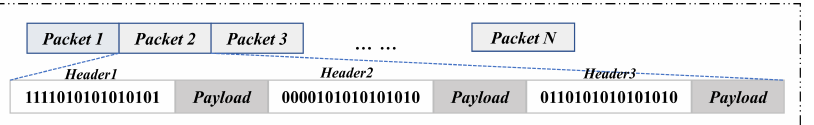
Figure 9. Offline processing of OCC decoding scheme. ( a – c ) are respectively R, G, and B signals of the raw column selected; ( d – f ) are respectively the R, G, and B signals of the selected column after enhancement; ( g ) Block diagram of the proposed offline OCC decoding scheme.